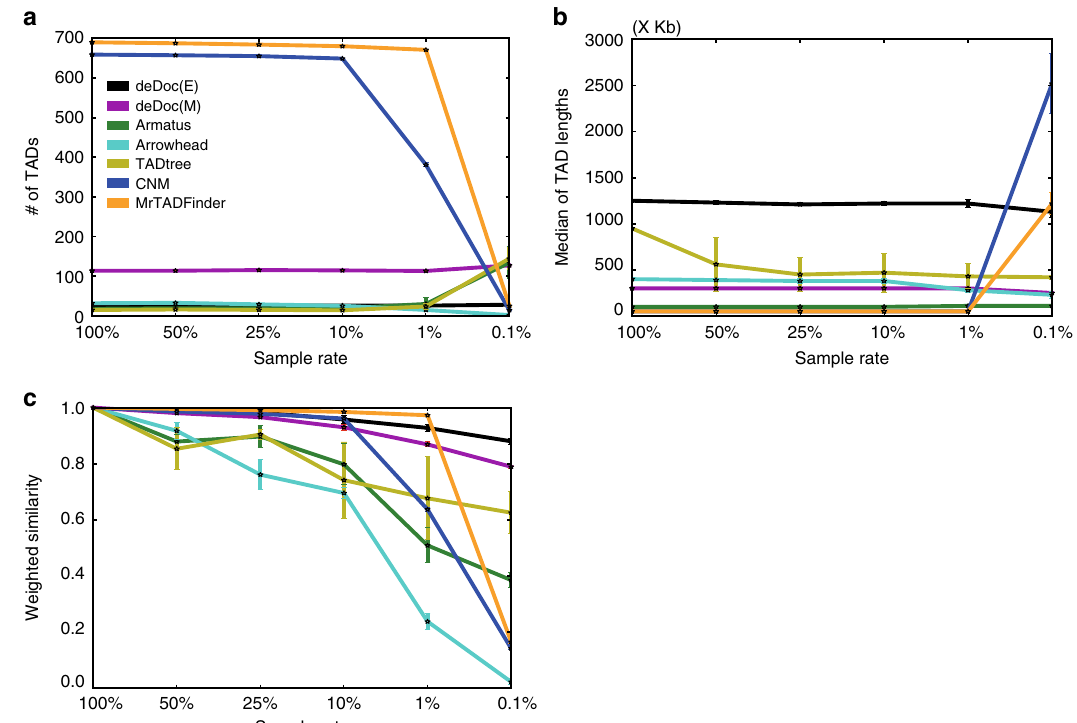
Fig. 2 deDoc is a robust TAD identi fi cation algorithm. 50, 25, 10, 1 and 0.1% of the data from chromosome 22 in GM12878 cells (Rao et al. 21 ) were sampled. a We compared the a the number of domains, b the lengths of the domains, and c weighted similarities of the TADs as identi fi ed using whole and down-sampled data. The error bars indicate s.d. from 50 replications of each experiment